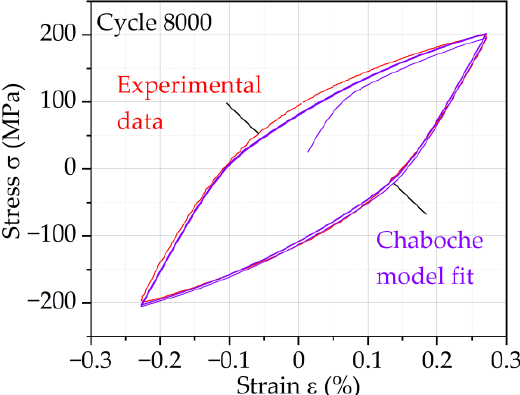
Table 3. Chaboche parameters for 240 °C, determined at load cycle 8000.